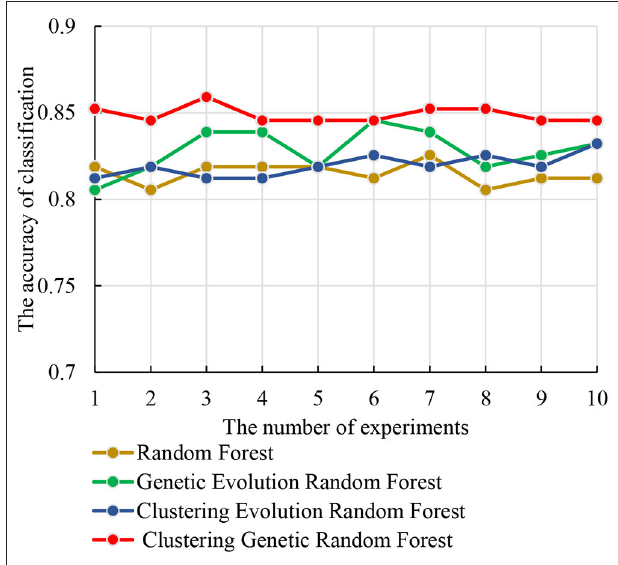
FIGURE 7 | The relationship curves of accuracy and the four models in 10 independent experiments.